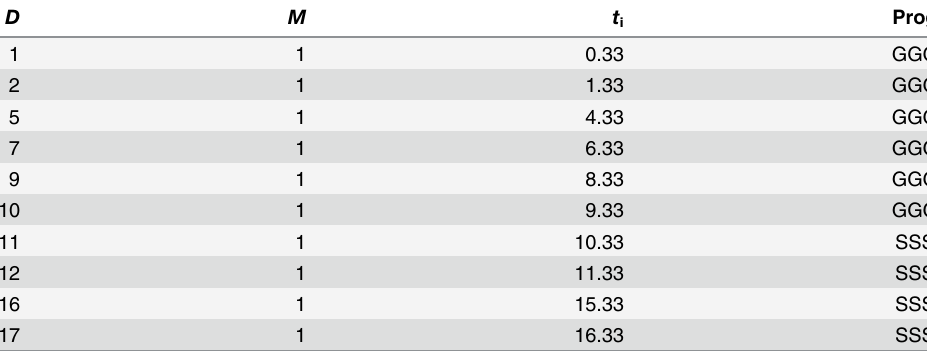
Table 4. The time points t i of all GGG and SSS dates in CC. D M